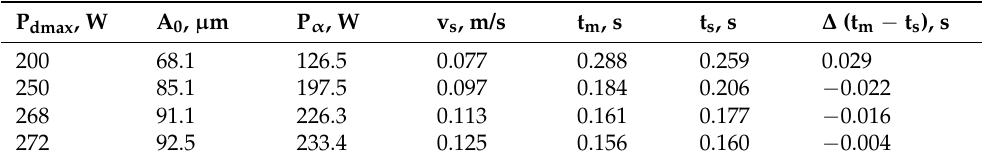
Table 2. Values of the vibrations, effective power, speed and welding time achieved by the ultrasonic rotary sonotrode depend on the specified electrical